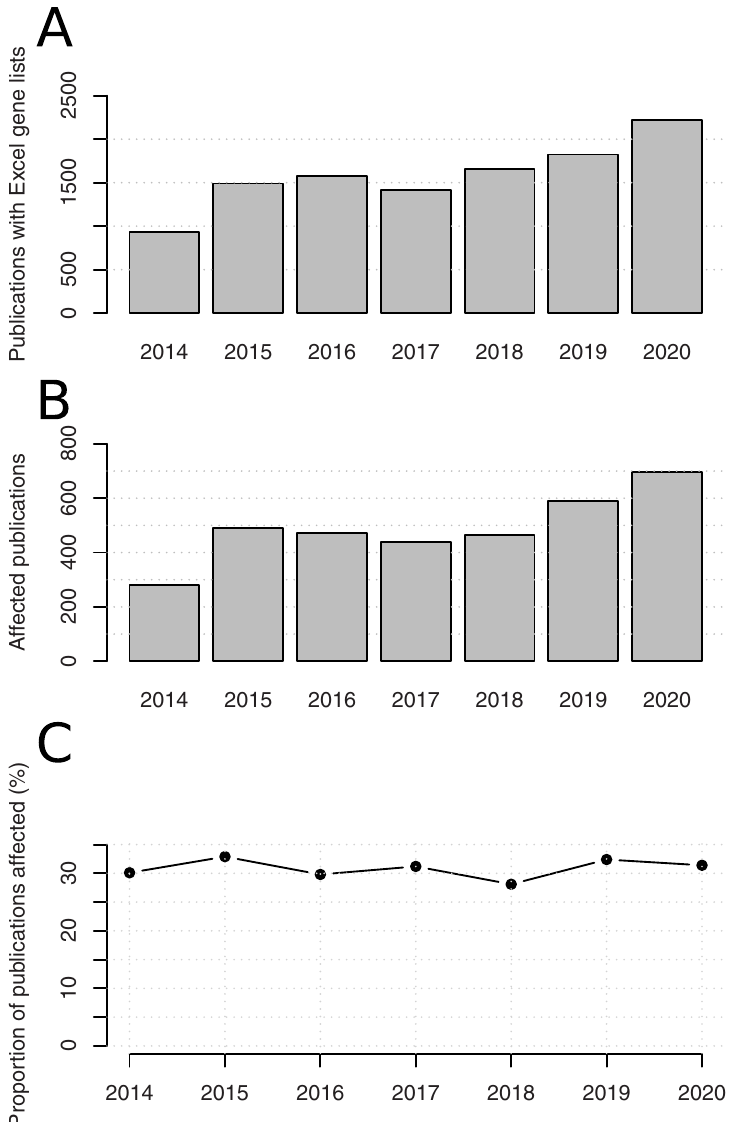
Fig 1. Prevalence of gene name errors in the period 2014–2020. (A) Publications with supplementary Excel gene lists. (B) Publications affected by gene name errors. (C) Proportion of affected publications.